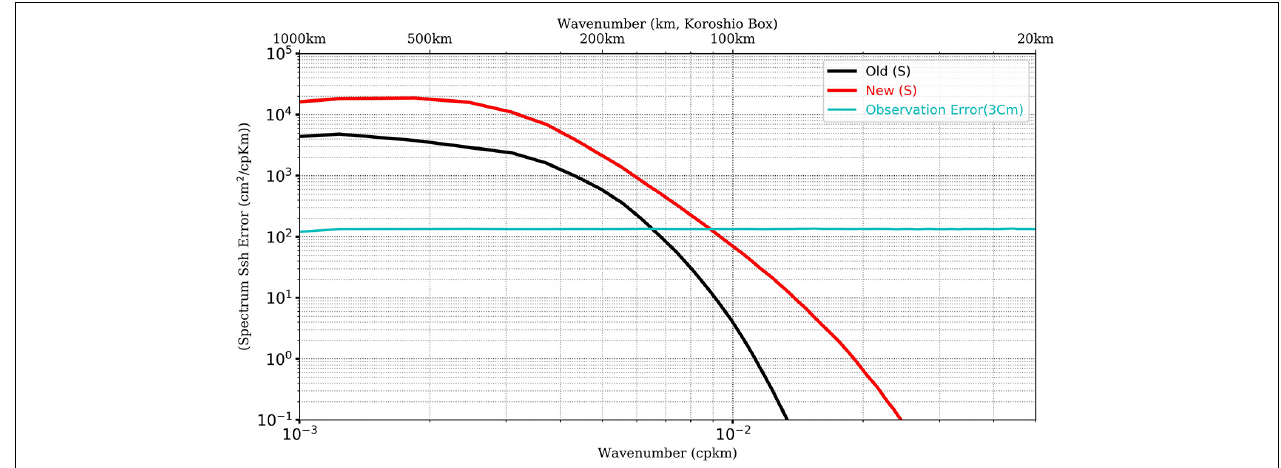
FIGURE 9 | The power spectral density of the anomalies calculated for the Sea Level (cm 2 /cpkm) in the Kuroshio region (150–162 ◦ W, 30–42 ◦ N, the black box in the Figure 12A ), for the new basis (red curve) and the old basis (black curve), cyan curve is observation error. Spectrum are average in time and space.